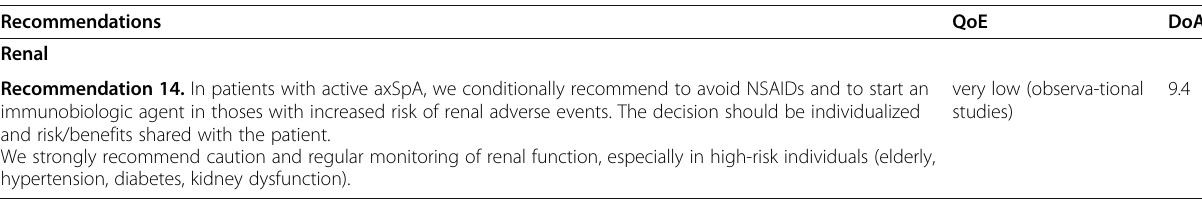
Table 1 Brazilian recommendations for the use of nonsteroidal anti-inflammatory drugs in patients with axial spondyloarthritis (Continued) Recommendations Renal Recommendation 14. In patients with active axSpA, we conditionally recommend to avoid NSAIDs and to start an immunobiologic agent in thoses with increased risk of renal adverse events. The decision should be individualized and risk/benefits shared with the patient. We strongly recommend caution and regular monitoring of renal function, especially in high-risk individuals (elderly, hypertension, diabetes, kidney dysfunction).